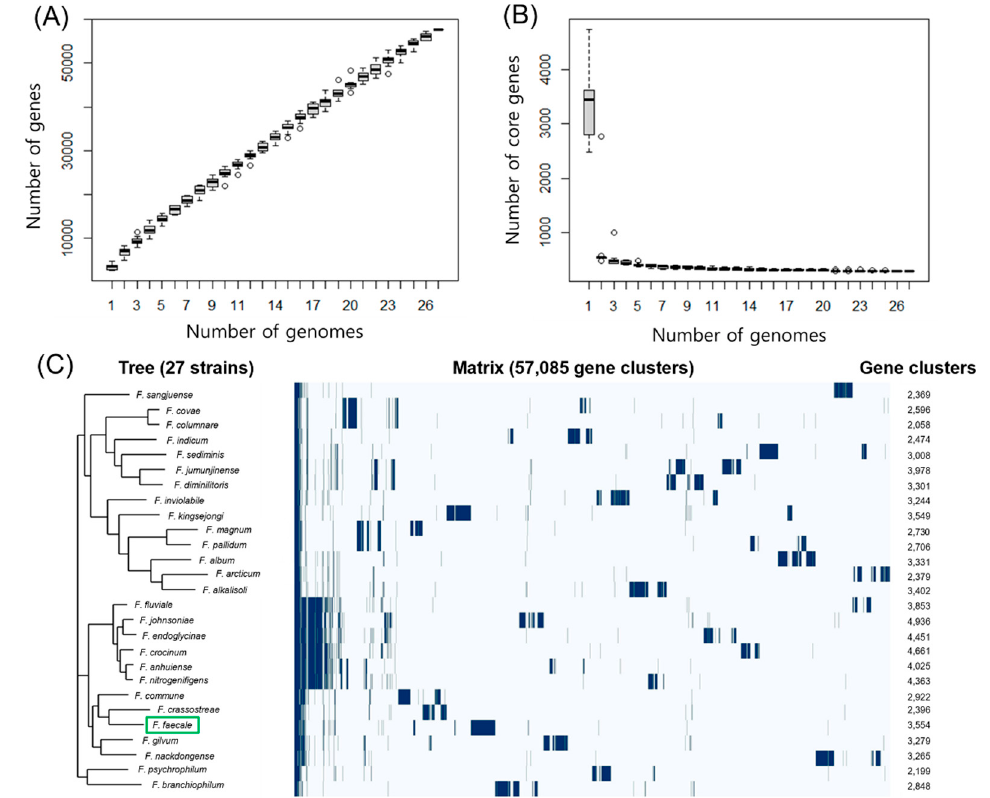
Figure 4. Pangenome analysis of 27 Flavobacterium strains including F. faecale WV33 T . ( A ) Box- Whisker plot of pangenome as a function of the number of genomes (1–27) of Flavobacterium strains . ( B ) Box-Whisker plot of core genome as a function of the number of genomes (1–27) of Flavobacterium strains . Outliers are shown as open circles. ( C ) Phylogenetic tree and a gene presence/absence matrix plot generated using Roary. Green box represents F. faecale WV33 T (GCF 003076455.1). In the matrix a blue line represents gene presence. The numbers on the right represent the total number of core and unique genes of each Flavobacterium strain.